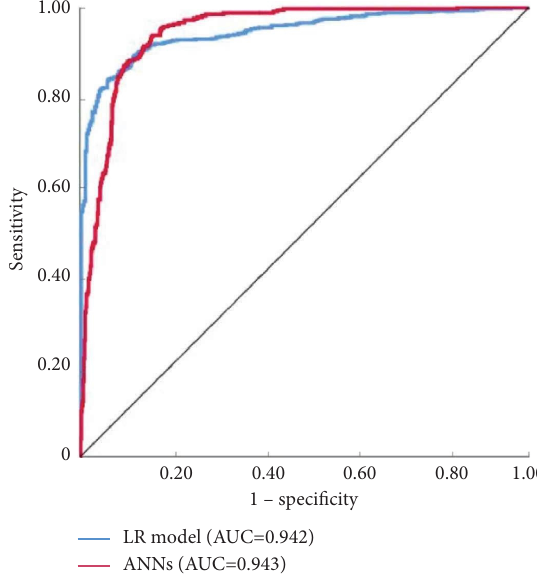
Figure 3: ROC curve of the ARDS prediction model in CAP patients based on an artifcial neural network model. Note. CAP, community-acquired pneumonia; ARDS, acute respiratory distress syndrome; AUC, the area under the ROC